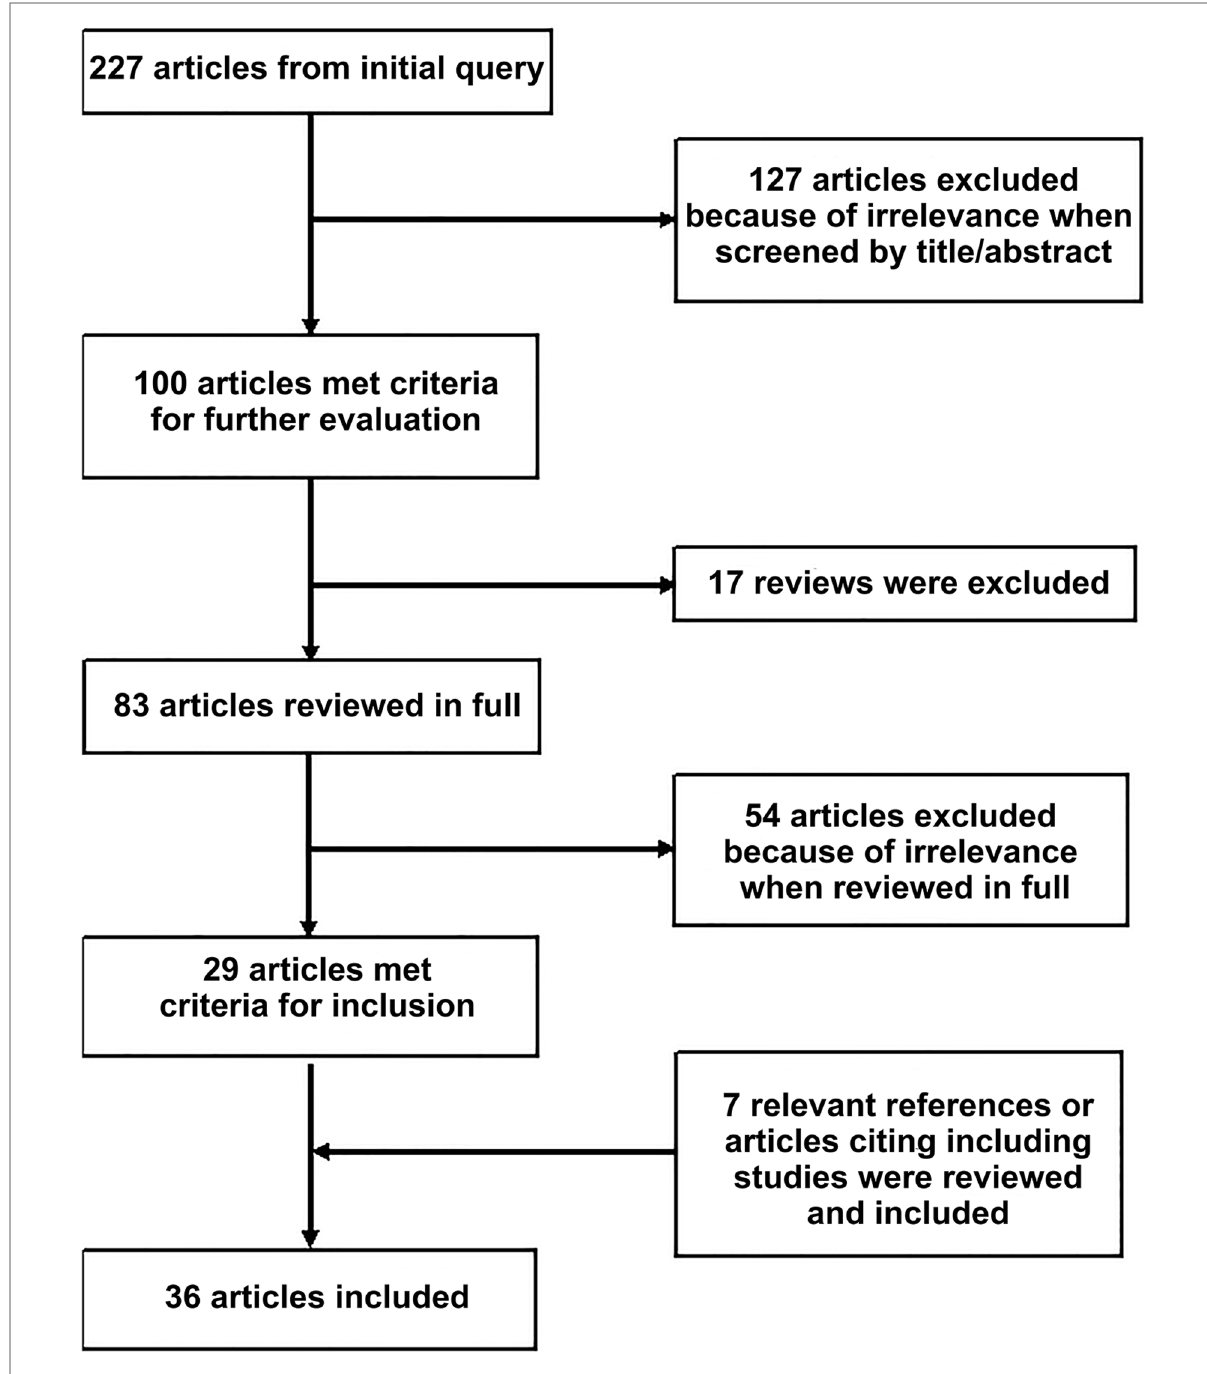
FIGURE 1 PRISMA fl ow chart illustrating article identi fi